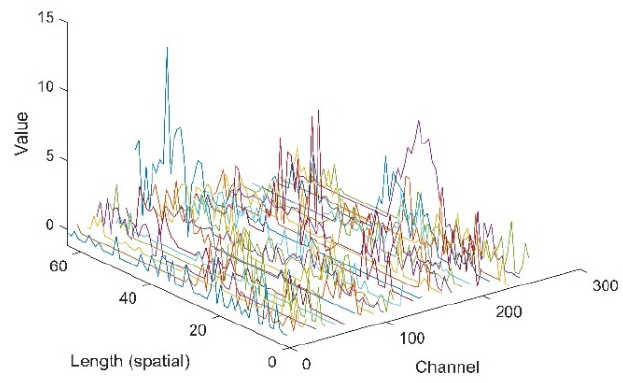
Figure 7. The features filtered by the layer before the attention unit.